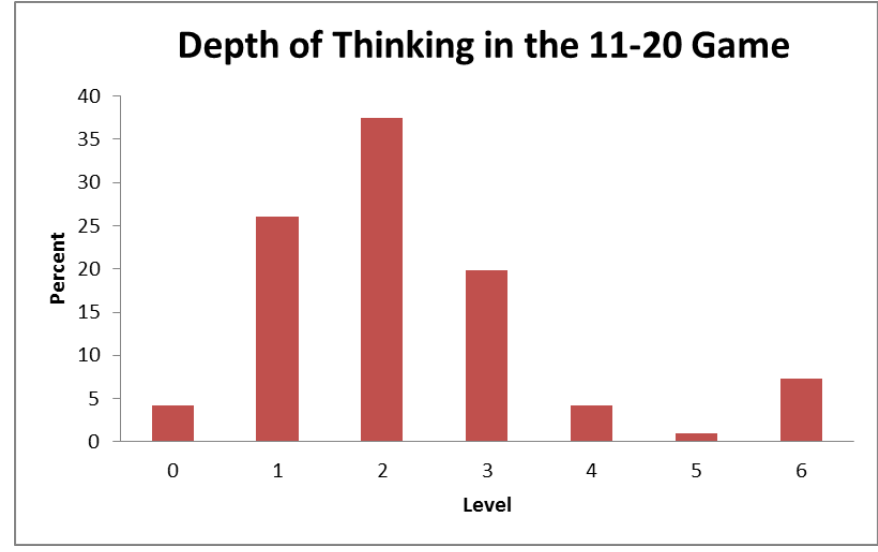
Figure 3. The Depth of Thinking in the 11-20 Game.